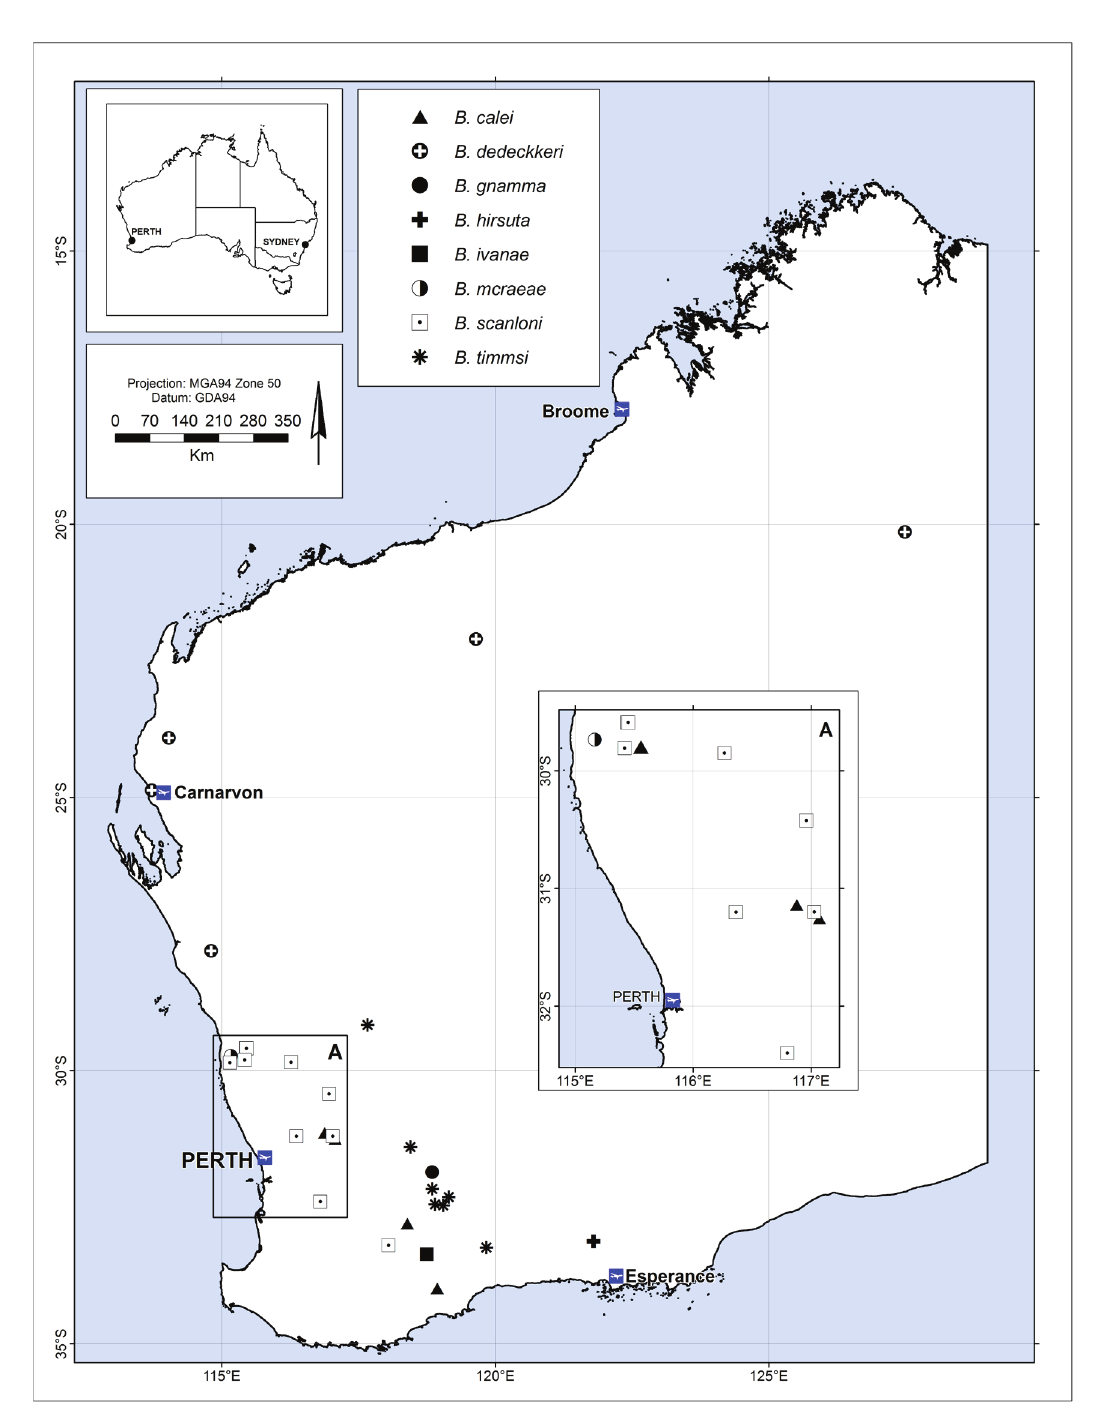
Fig. 1. Map of Western australia with localities of Bennelongia - species described in the present